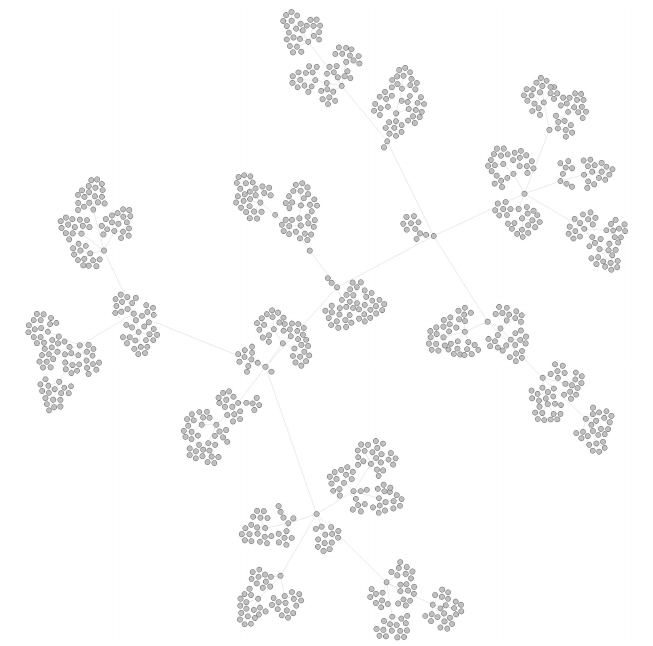
Figure 4. A simulated COVID-19 transmission network with 1000 nodes.